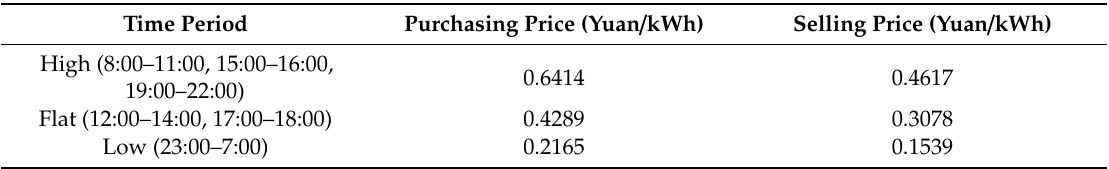
Table 10. Time-of-use tariff of agricultural electricity in Gansu.